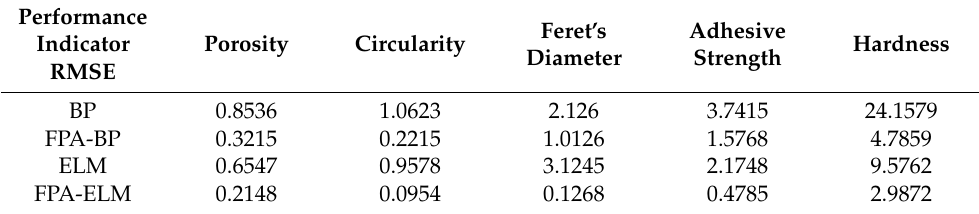
Table 3. The RMSE prediction comparison results of the five parameters of the BP, FPA-BP, ELM and FPA-ELM model.